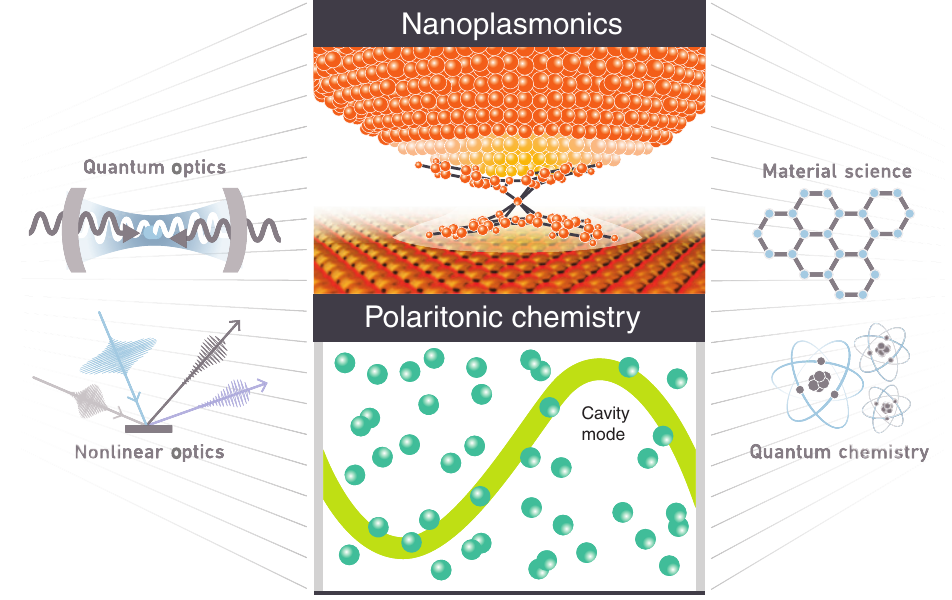
Figure 1: Nanoplasmonic structures as well as polaritonic chemistry use strong light-matter interactions. Both fields benefit from generalized methods from more established fields, such as ab initio materials science, quantum chemistry, quantum optics, and nonlinear optics, among others. Our review discusses this exciting intersection of fields and presents recent results in polaritonic chemistry and quantum optics at the atomic scale from a theoretical and computational